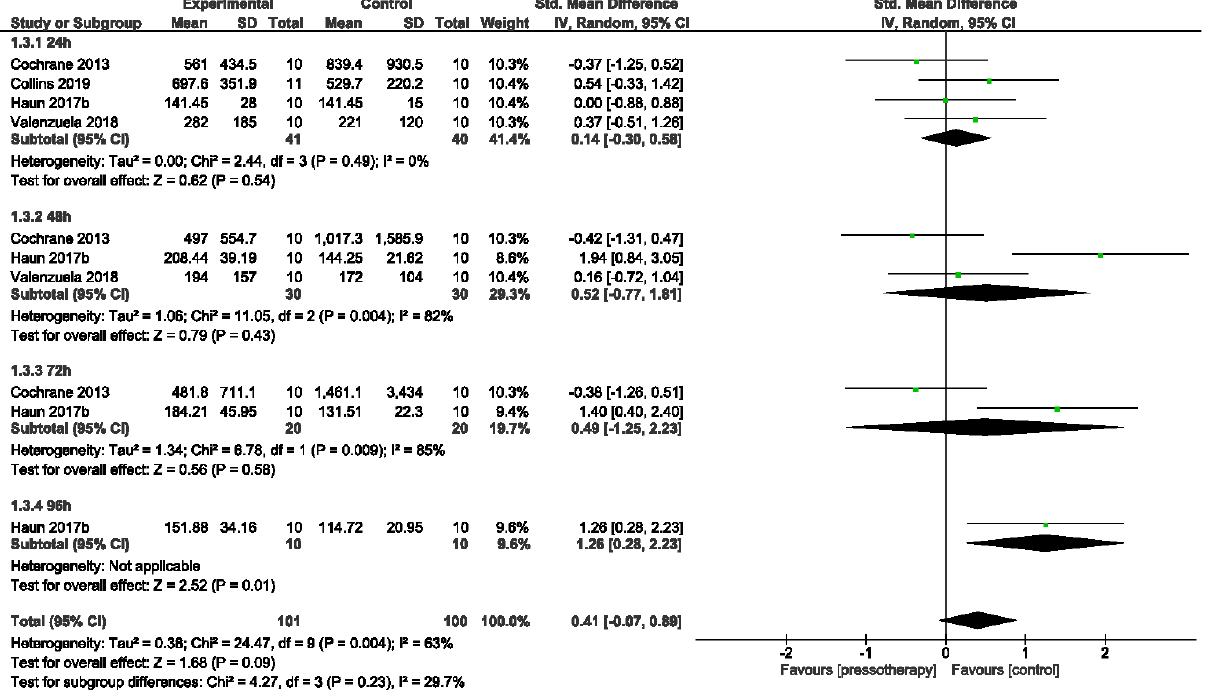
Figure 6. Effects of pressotherapy on serum CK activity from 24 h to 96 h after